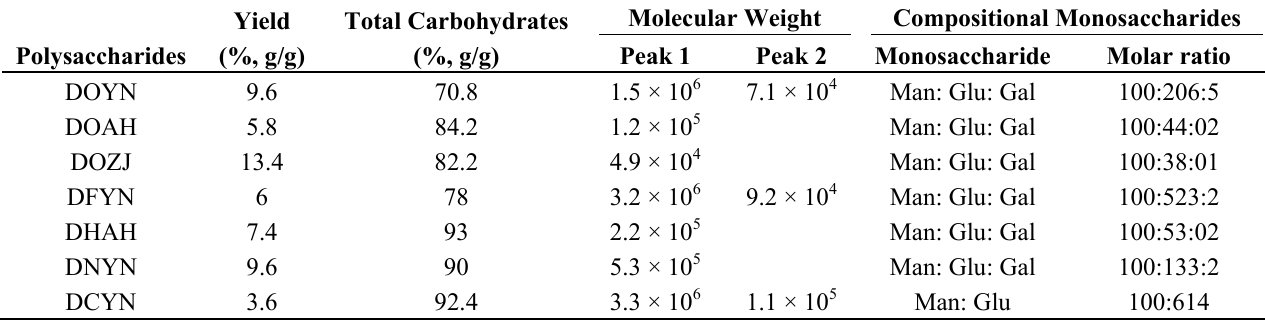
Table 1. Yield, carbohydrate content, molecular weight and compositional monosaccharide of crude polysaccharides from Dendrobium. Polysaccharides